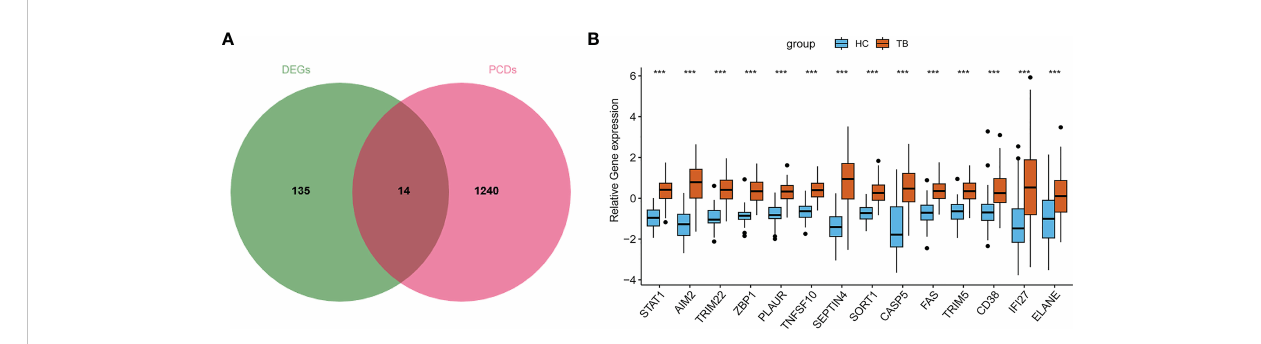
FIGURE 4 Screening of PCD-related genes in TB. (A) The overlap between DEGs and PCD-related genes. (B) Overall expression levels for PCD-related genes in TB patients.